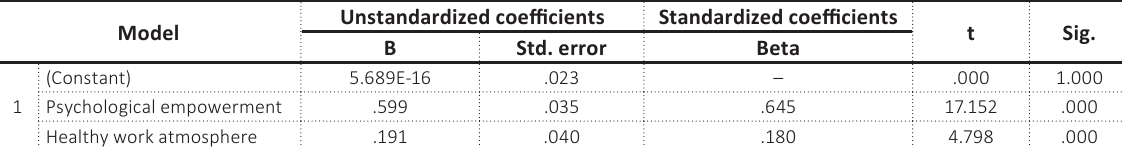
Table 4. Multiple linear regression model of the influence of psychological empowerment and employer brand dimensions on employee